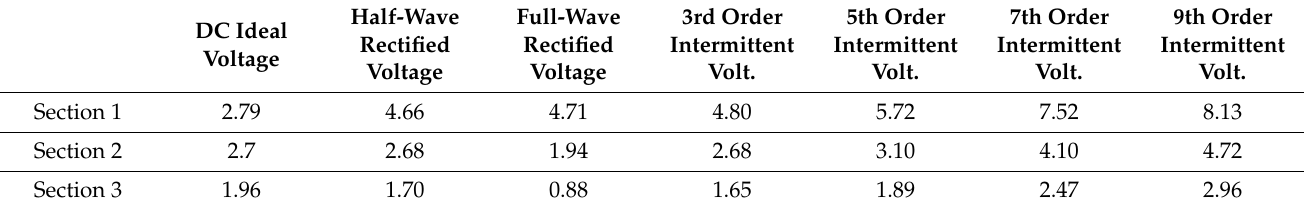
Table 8. Space charge density ( µ C/m 3 ) for various supply voltages, a 2 mm dust layer on the collector surfaces, and dust resistivity 10 12 Ω × cm.